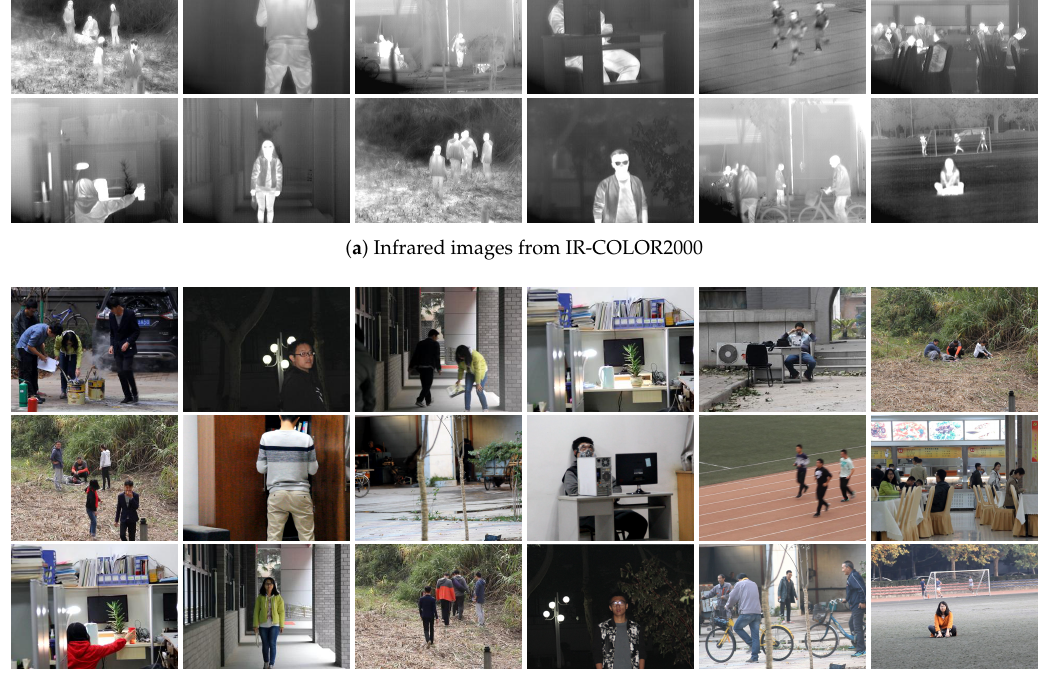
Figure 2. Dataset Section 2.3 of IR-COLOR2000( the scene in outdoor and indoor ), ( a ) Infrared images from IR-COLOR2000, ( b ) RGB images from